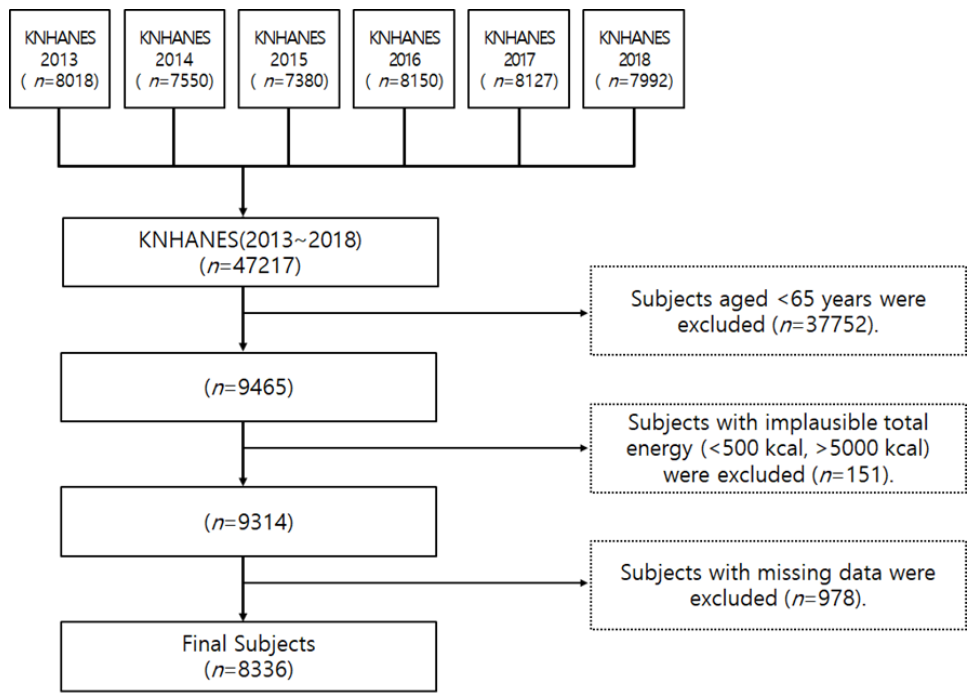
Figure 1. Flowchart of the selection of subjects in this study.